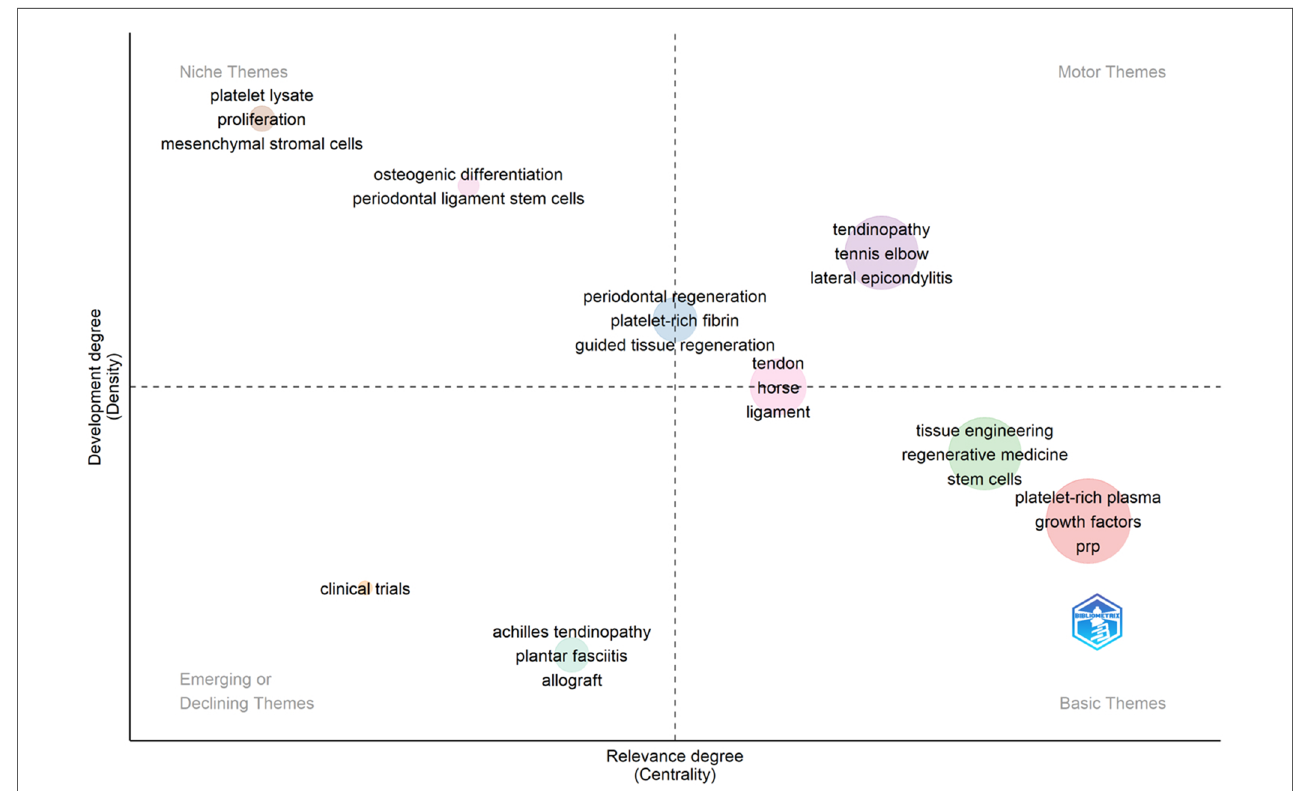
FIGURE 8 Thematic map of using platelet-rich plasma to treat ligament and tendon